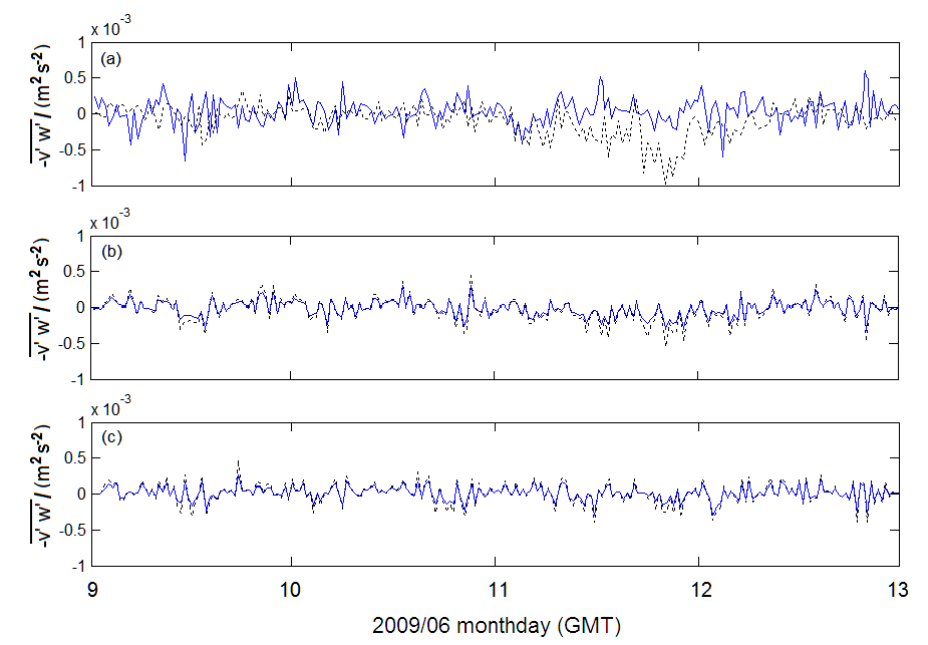
Fig. 12. Time series of Reynolds stresses calculated using the VF method (solid line) and uncorrected (dashed line) Reynolds stress time series at (a) 12, (b) 9 and (c) 7 mab.